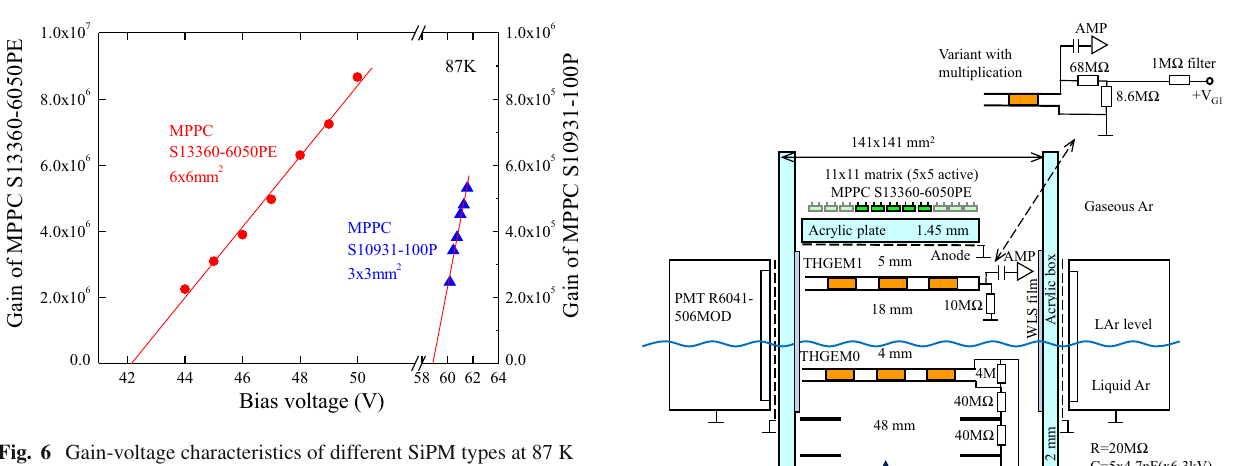
Fig. 6 Gain-voltage characteristics of different SiPM types at 87 K